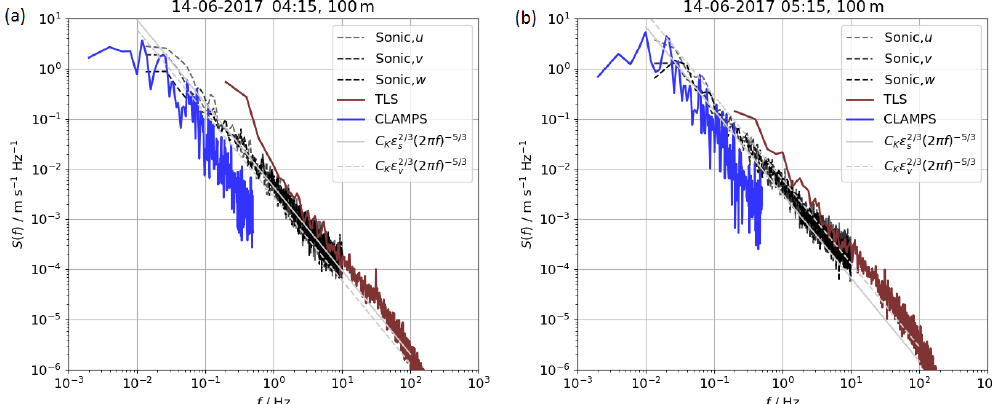
Figure C1. Variance spectrum of TLS (between 90 and 110m above the ground), vertical stare, and sonic anemometer at 100m above ground for the time period 04:00–04:30UTC (a) and 05:00–05:30UTC (b)